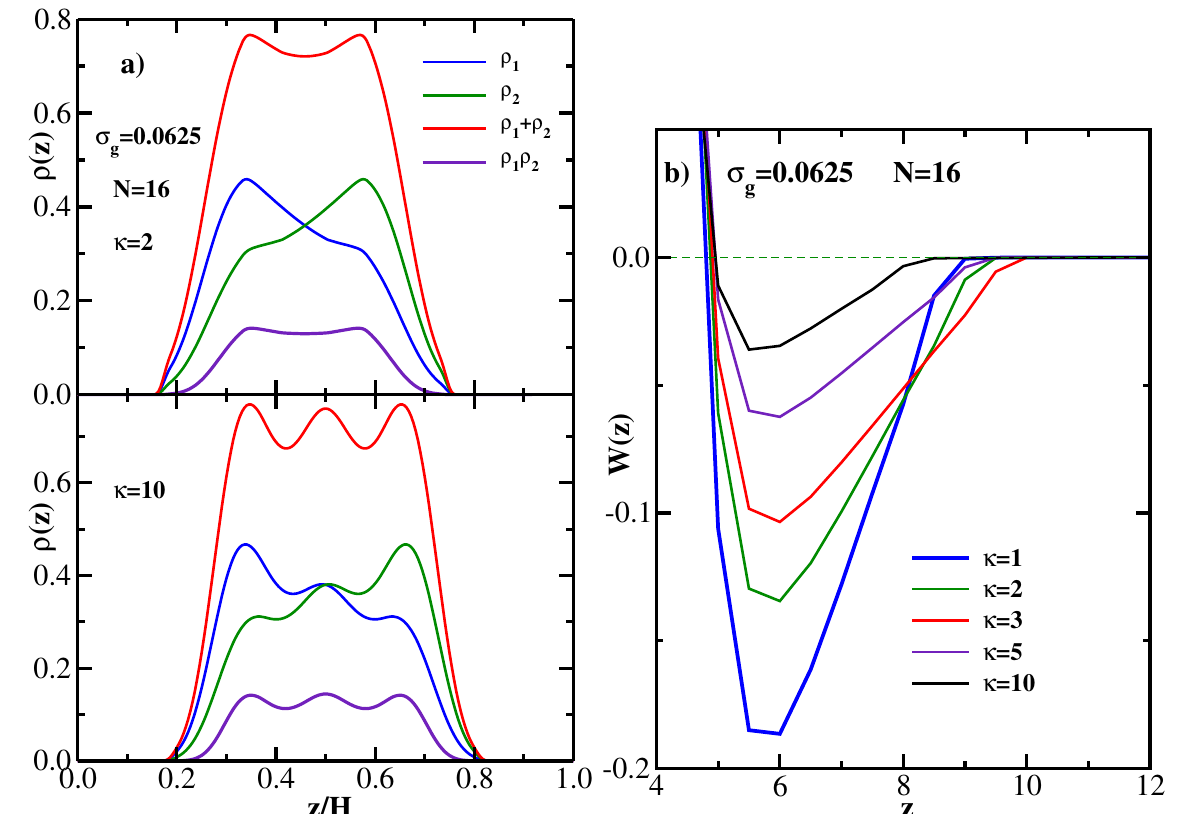
Figure 3. ( a ) Upper panel: DFT results for the equilibrium monomer density distributions for two monodisperse semiflexible brushes at equilibrium separation H vs z / H ; grafting density is σ g = 0.0625, grafted chain length is N = 16, and the chain stiffness parameter is κ = 2. ρ 1 ( z ) is the monomer density distribution of the brush grafted at the left wall ( z g 1 = 0), ρ 2 ( z ) is the monomer density distribution of the brush grafted at the right wall ( z g 2 = H ). The sum ρ 1 ( z ) + ρ 2 ( z ) and the product ρ 1 ( z ) ρ 2 ( z ) of the two profiles are also shown. Lower panel: same as the upper panel but for the chain stiffness parameter κ = 10. ( b ) PMF between two monodisperse semiflexible brushes as a function of wall-wall separation at the grafting density σ g = 0.0625 and the grafted chain length N = 16 for five values of the grafted chain stiffness parameter κ , as